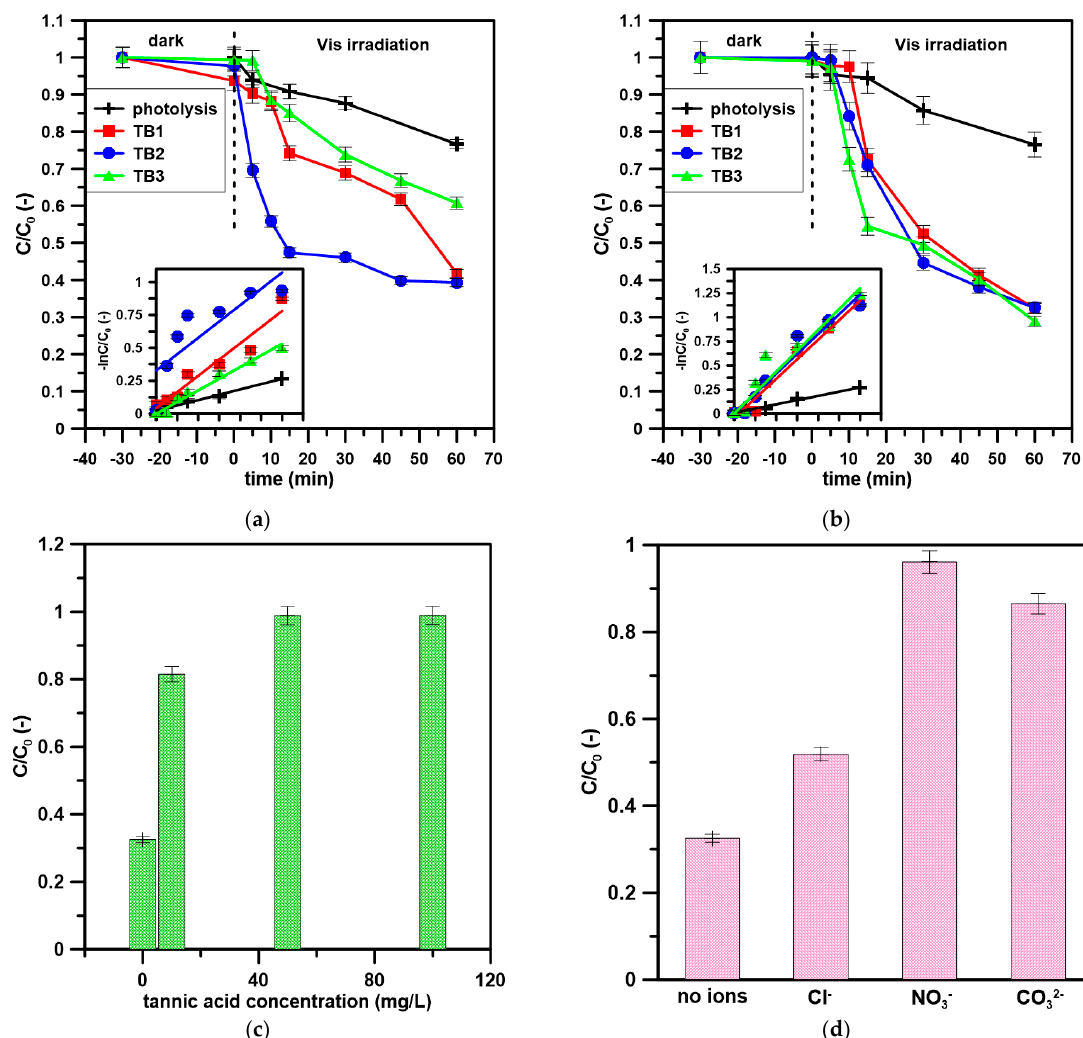
Figure 3. SEM images of the photocatalysts: ( a ) TB1 with magnification 5 kx; ( b ) EDS spectra of TB1; ( c ) TB2 with magnification 200×; ( d ) EDS spectra of TB2; ( e ) TB3 with magnification 5 kx; ( f ) EDS spectra of TB3.